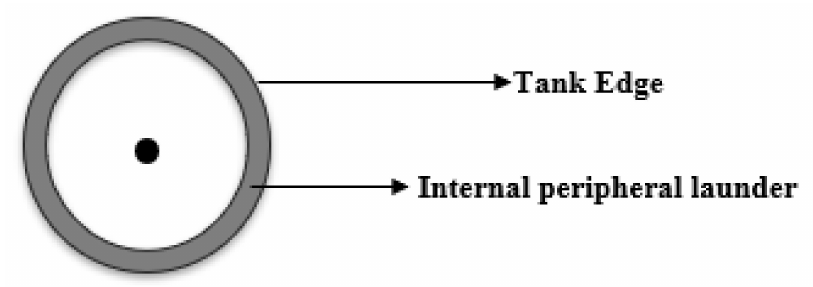
Figure 5. Internal peripheral launder [71].